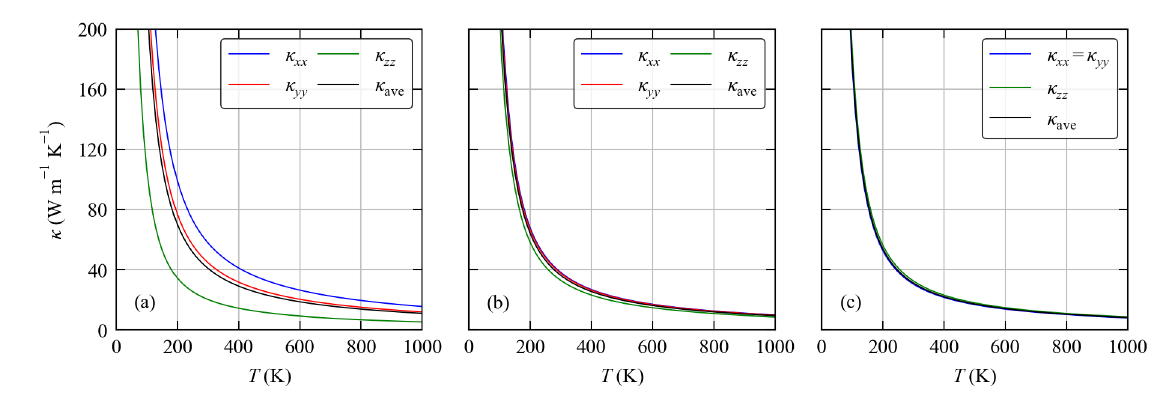
Figure 10. Anisotropy in the lattice thermal conductivity of the o C24 ( a ), K-V/C-VI ( b ) and K-VII/C-V ( c ) structures. For the orthorhombic structures shown in ( a , b ) the three diagonal components of the κ latt tensor, κ xx , κ yy and κ zz are shown together with the average κ ave defined in Equation (15). For the hexagonal K-VII/C-V structure shown in ( c ) the κ xx and κ yy are equivalent, and κ xx = κ yy is shown together with κ zz and κ ave